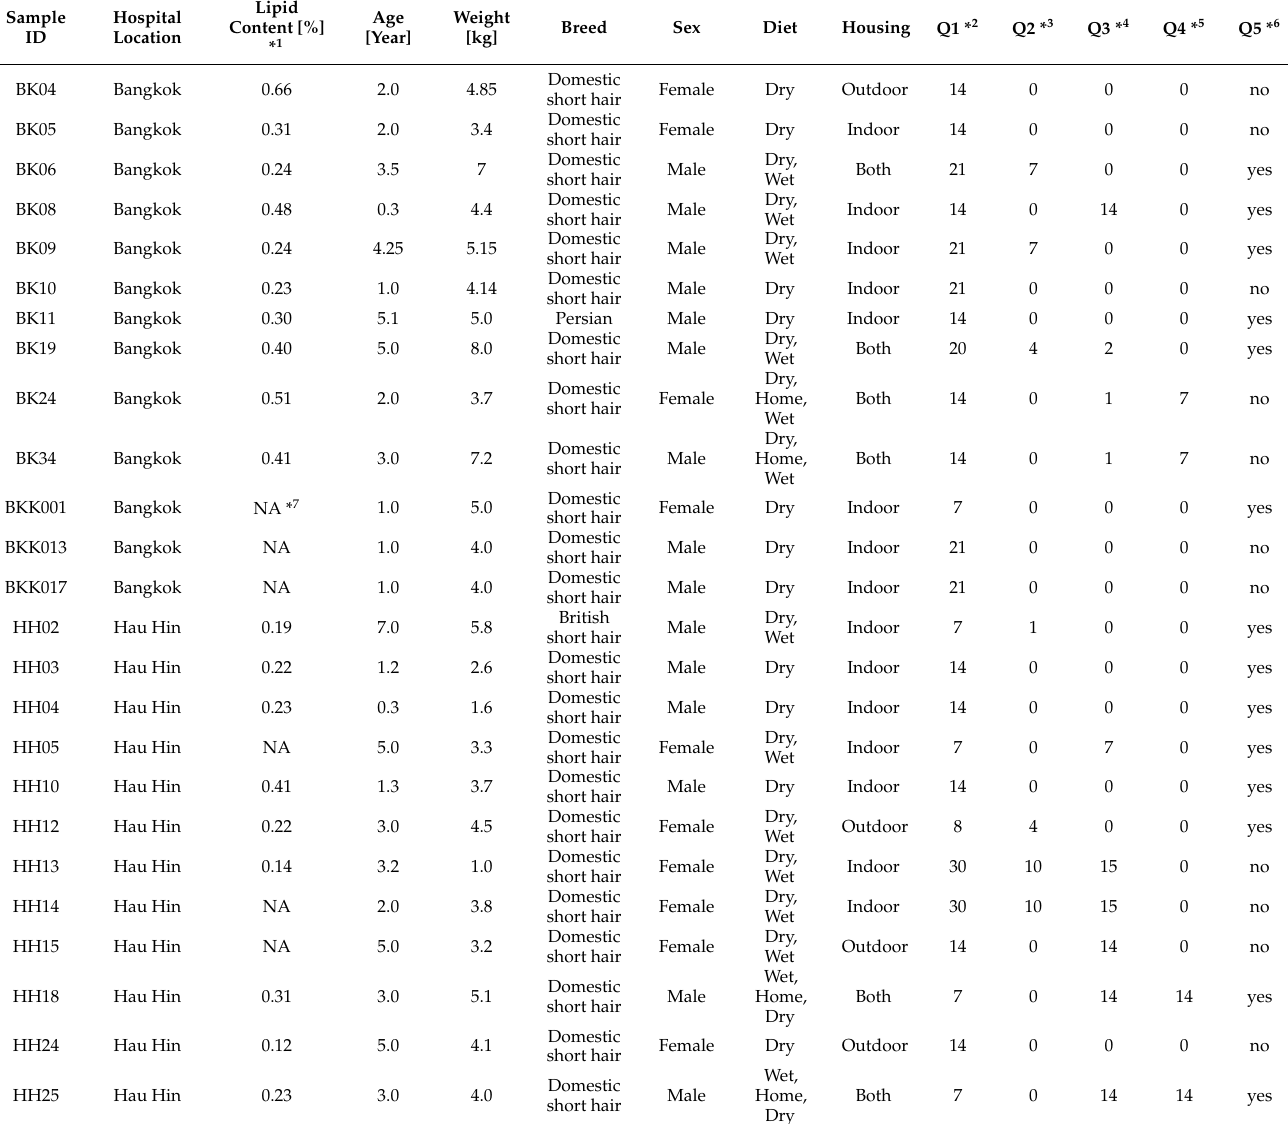
Table 1. Sample information of pet cats obtained from the